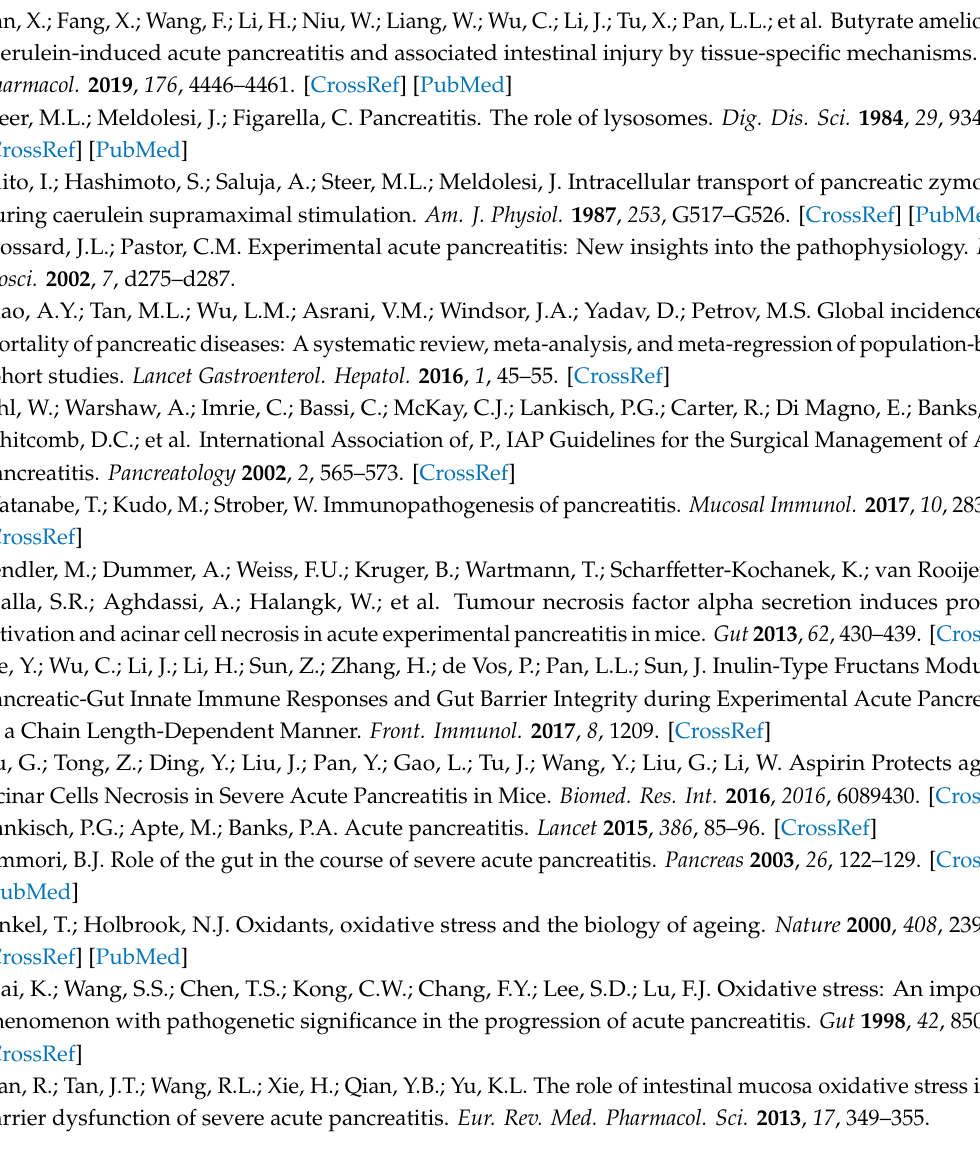
Figure S1: Hematoxylin and eosin staining of pancreas and colon